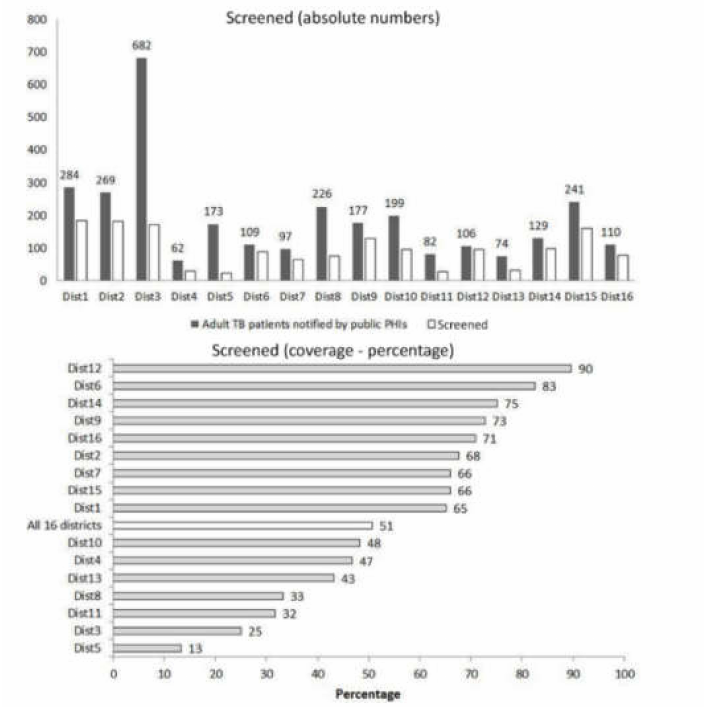
Figure 1. Screening ($) for ‘high risk of severe illness’ (absolute numbers and percentage) at no- tification among adults ( ≥ 15 years) with TB (without known drug-resistant disease at diagnosis) from public health facilities of 16 districts in Karnataka, India, 15 October to 30 November 2020 (n = 3020). TB—tuberculosis; ($) defined as filling and syncing of screening details in a mobile application irrespective of the extent of missing